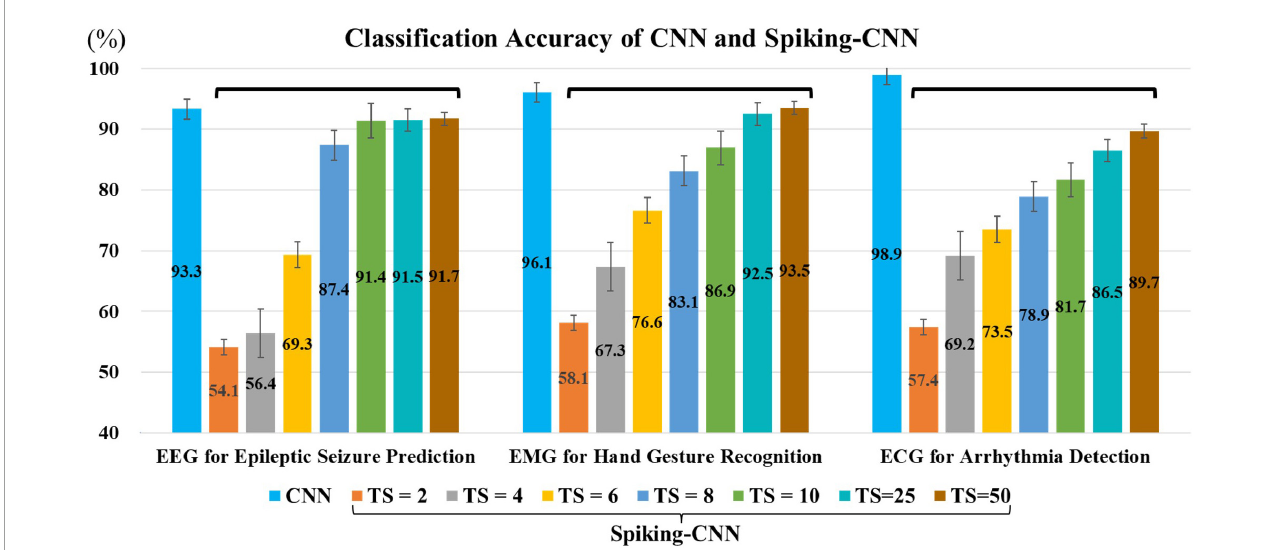
FIGURE5 Classification accuracies for electroencephalography (EEG), electromyography (EMG), and electrocardiography (ECG) utilizing convolutional neural network (CNN) and Spiking-CNN with different configurations in time step, where “TS” stands for “the number of time steps” for Spiking-CNN. The larger TS is set, the higher accuracies are gained.